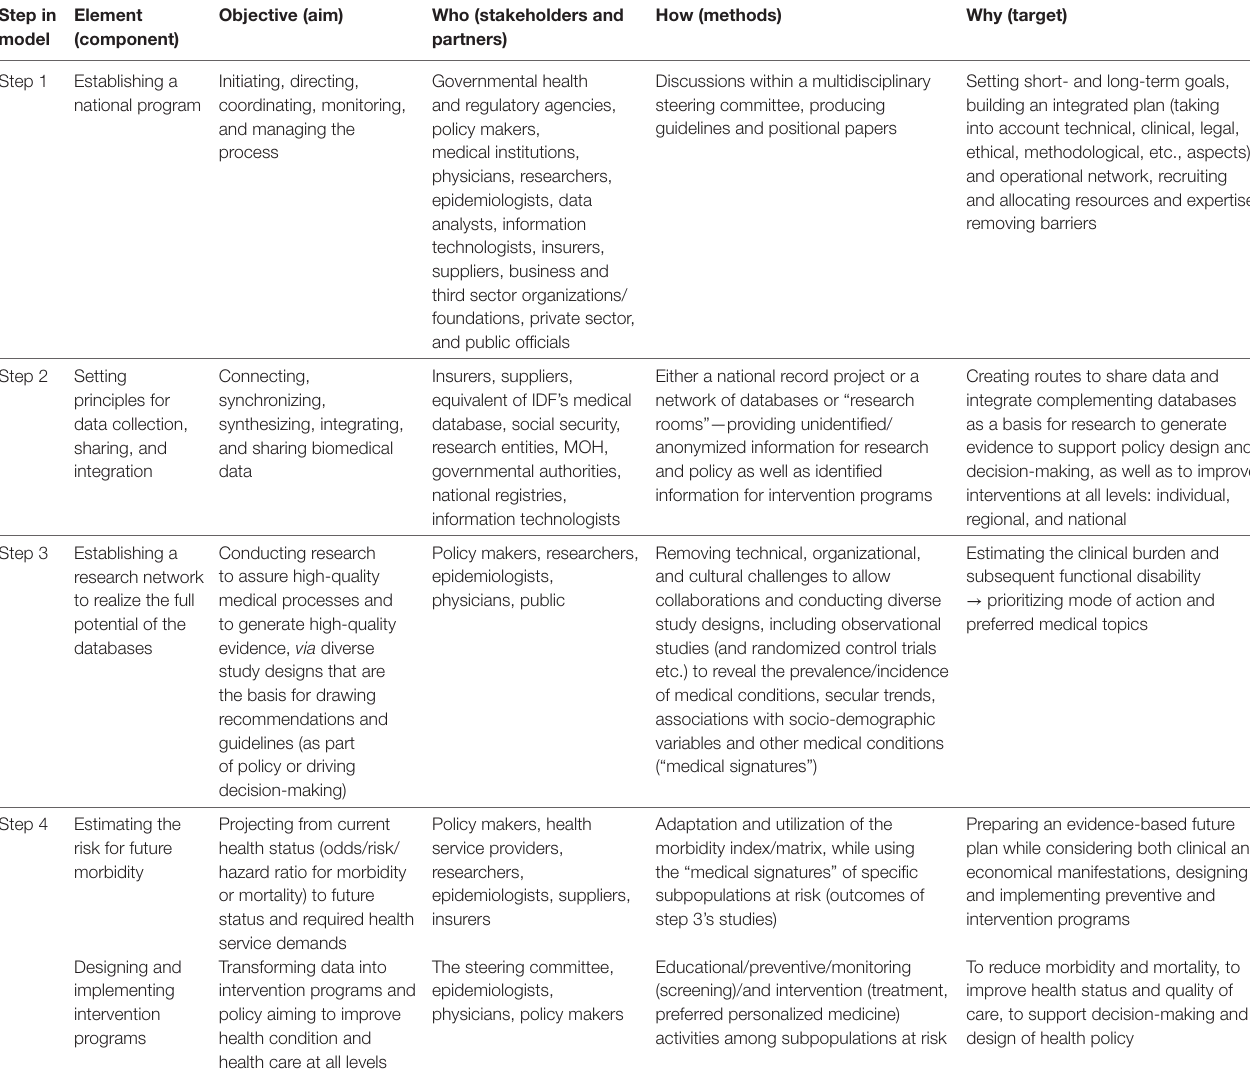
TaBle 1 | Key elements for information-driven policy—recommended components, objectives, stakeholders and partners, methods, and